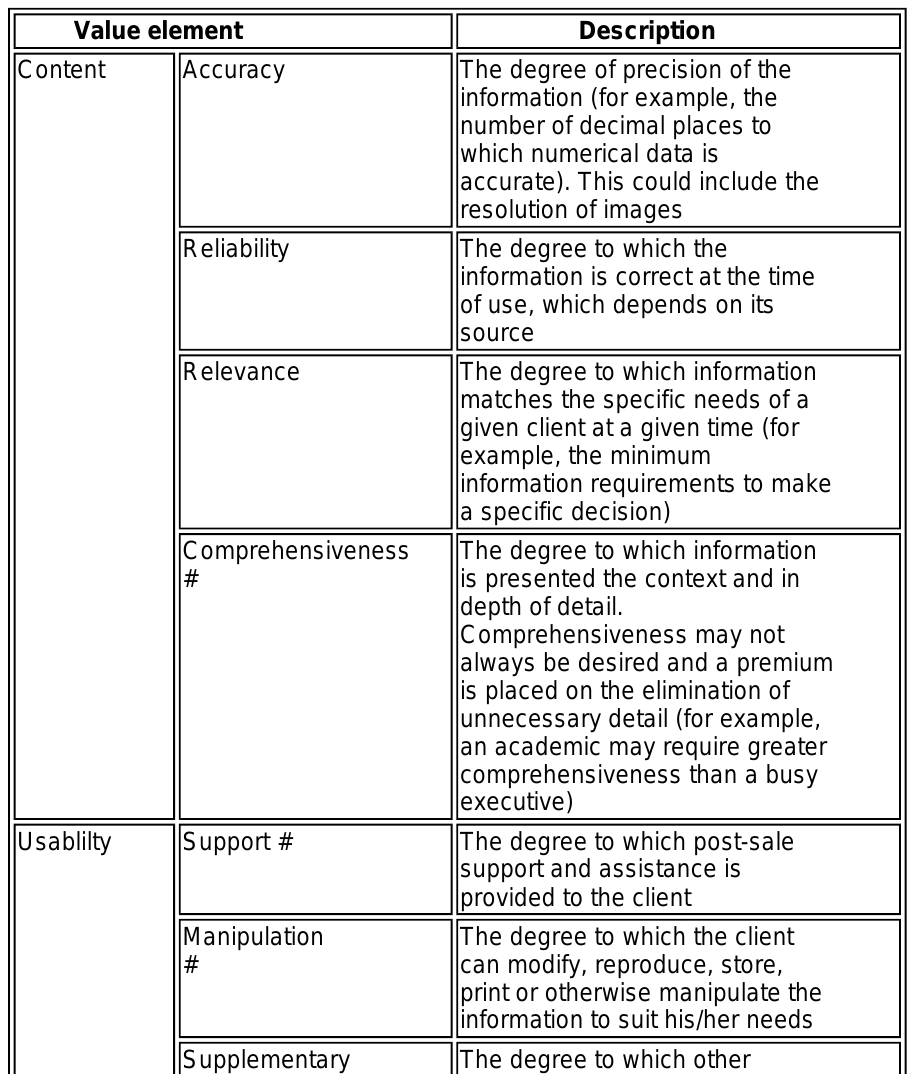
Table 1 List of 15 possible components of information product value, grouped into broader categories. (The elements marked with a # were taken from Shapiro and Varian